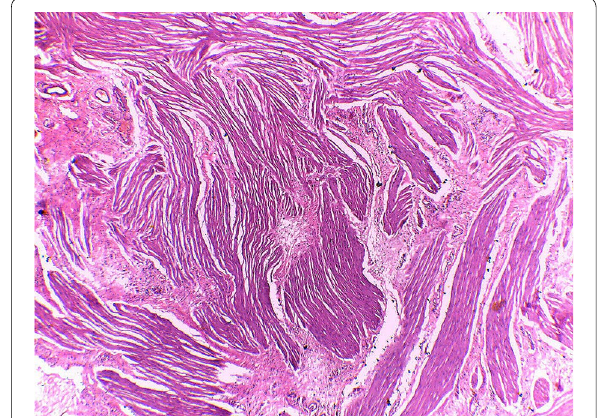
Fig. 1 Basophilic fibrocollagenous bundles in eosinophilic background “HX&Eosin